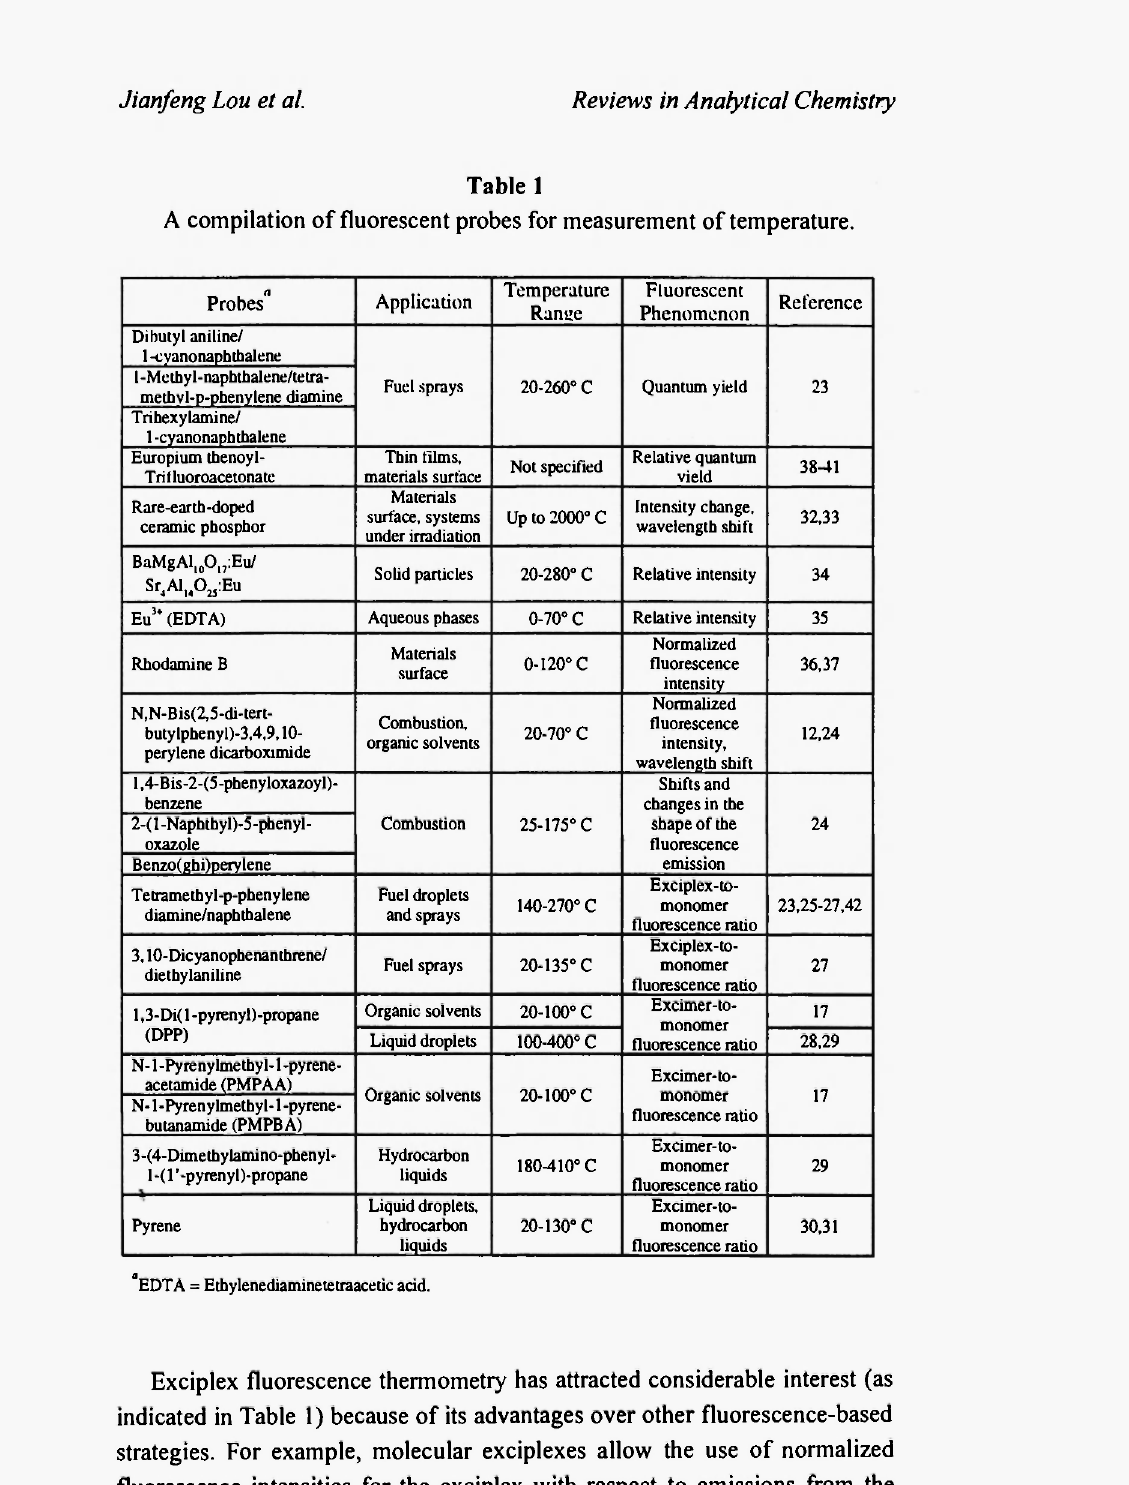
A compilation of fluorescent probes for measurement of